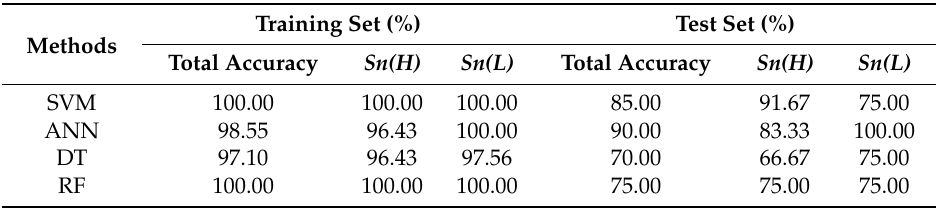
Table 3. Classification results of the training and the test sets obtained by the four methods. Sn(H) and Sn(L) are Sensitivity and Specificity,